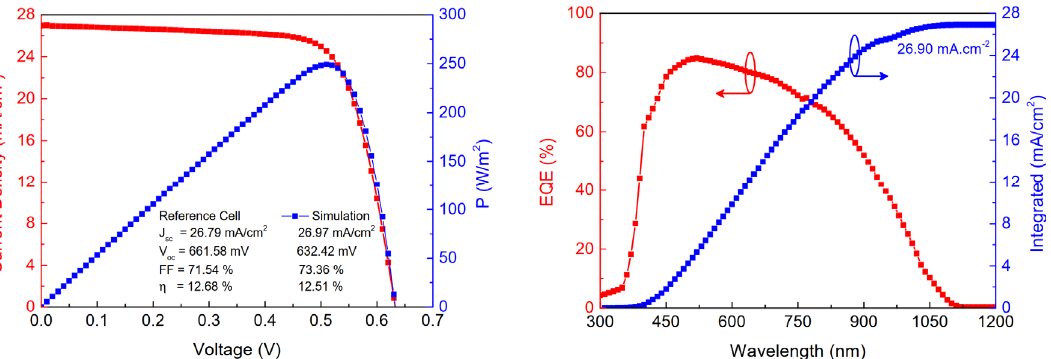
Figure 4. J–V curve, power, EQE spectrum, and integrated current density of the calibrated u-CIGS model, as ref [1]. Table 1. Investigated model characteristics.